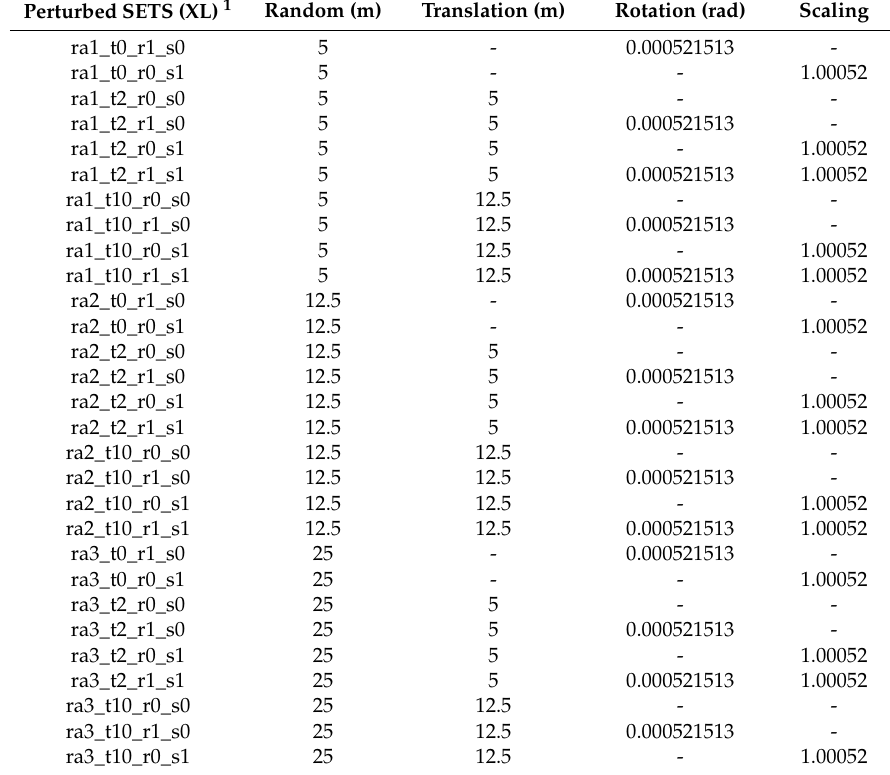
Table 3. Perturbed set of lines used in this application for CL1 to CL5 classes: combined random and systematic